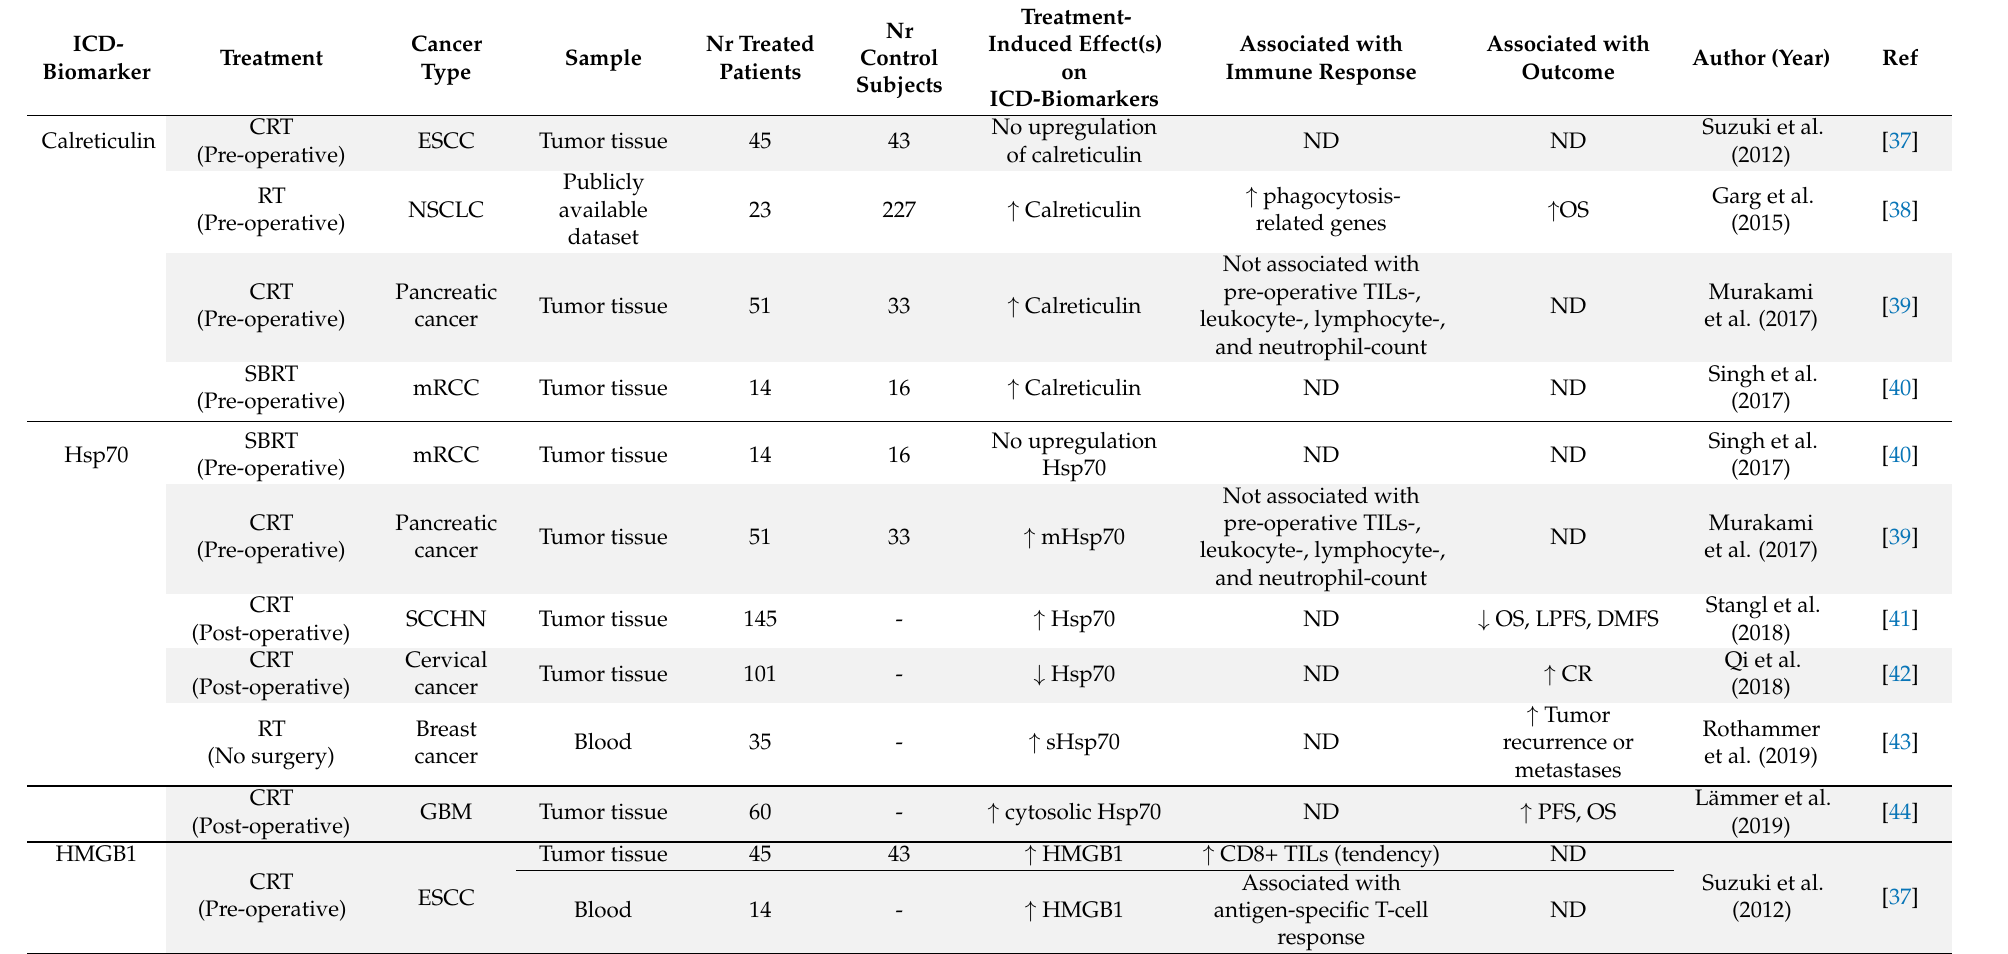
Table 1. Potential biomarkers of RT-induced immunogenic cell death in cancer